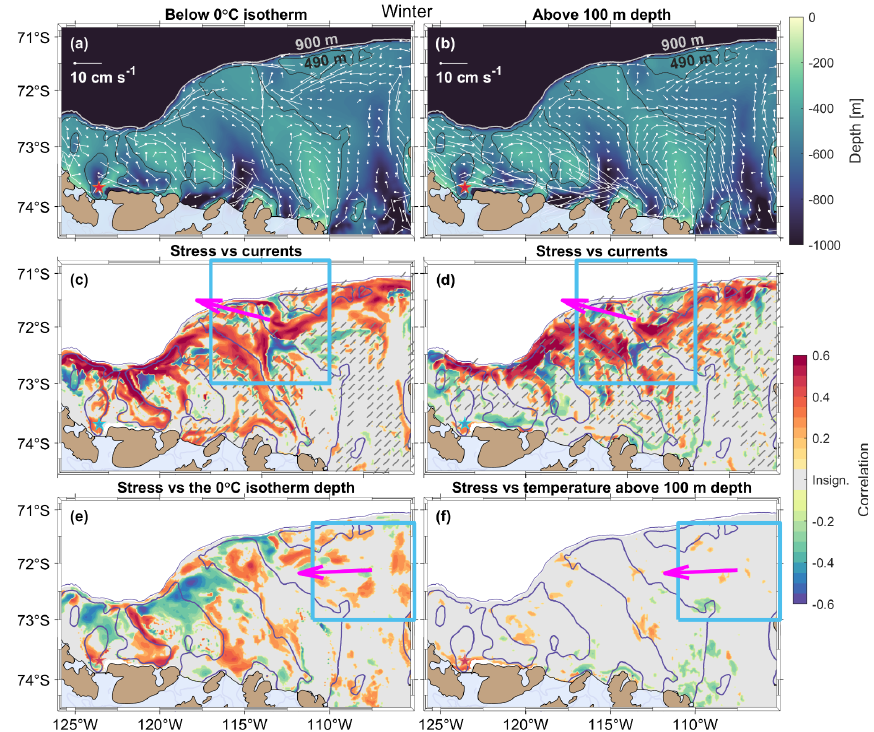
Figure 9. (a, b) Bathymetry (color) and mean modeled currents (white sticks, 2016 to mid-2017) at every 7th regional model grid point during winter (a) below the 0 ◦ C isotherm, and (b) above a depth of 100m. The current scale is indicated in the top left corner, and the current is directed from the white circle indicating the grid cell center. Currents weaker than 1cms − 1 are omitted. The red star indicates GC 6 . (c, d) Maps of correlation between modeled currents and the zonal τ ERA-I averaged over the Central box (cyan) (c) below the 0 ◦ C isotherm and (d) above a depth of 100m. Gray regions have an insignificant correlation, and the white region is outside the on-shelf study domain. Hatched regions have mean currents less than 1cms − 1 . Panels (e) and (f) are analogous to panels (c) , (d) , but show correlation between the zonal τ ERA-I averaged over the East box (cyan) and (e) the depth of the 0 ◦ C isotherm, and (f) temperature above a depth of 100m. The contours shown are the 900m (thin blue line) and 490m (thick blue line) isobaths. The magenta arrow shows the direction of the mean τ ERA-I over the boxes. In (c) , (d) , (e) , (f) all time series are de-seasoned and LP 8D is applied, and the color of the star shows the correlation between τ ERA 5 and the along-trough current (c, d) and mCDW temperature (e, f) from Fig.